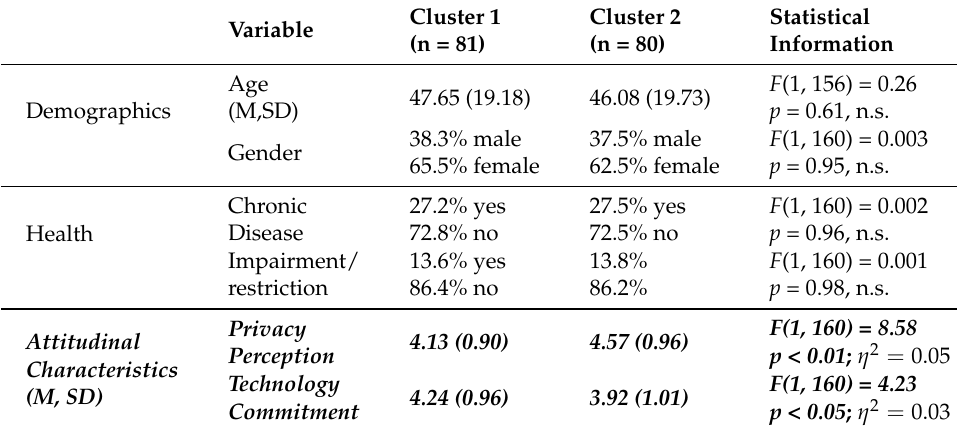
Table 1. Individual characteristics of both identified